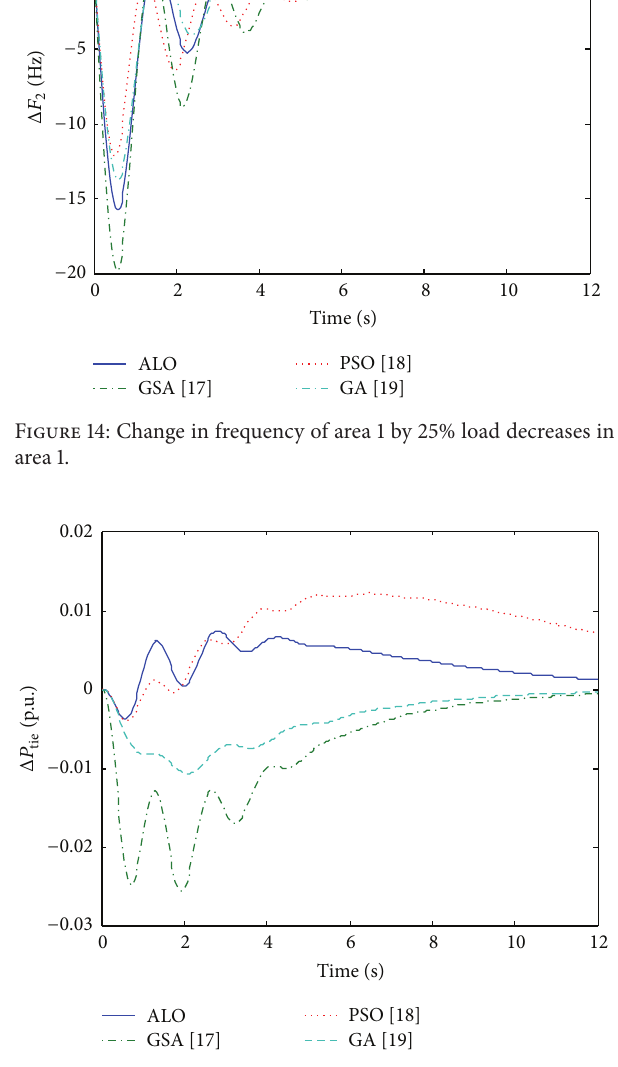
Figure 15: Change in tie-line power by 25% load decreases in area